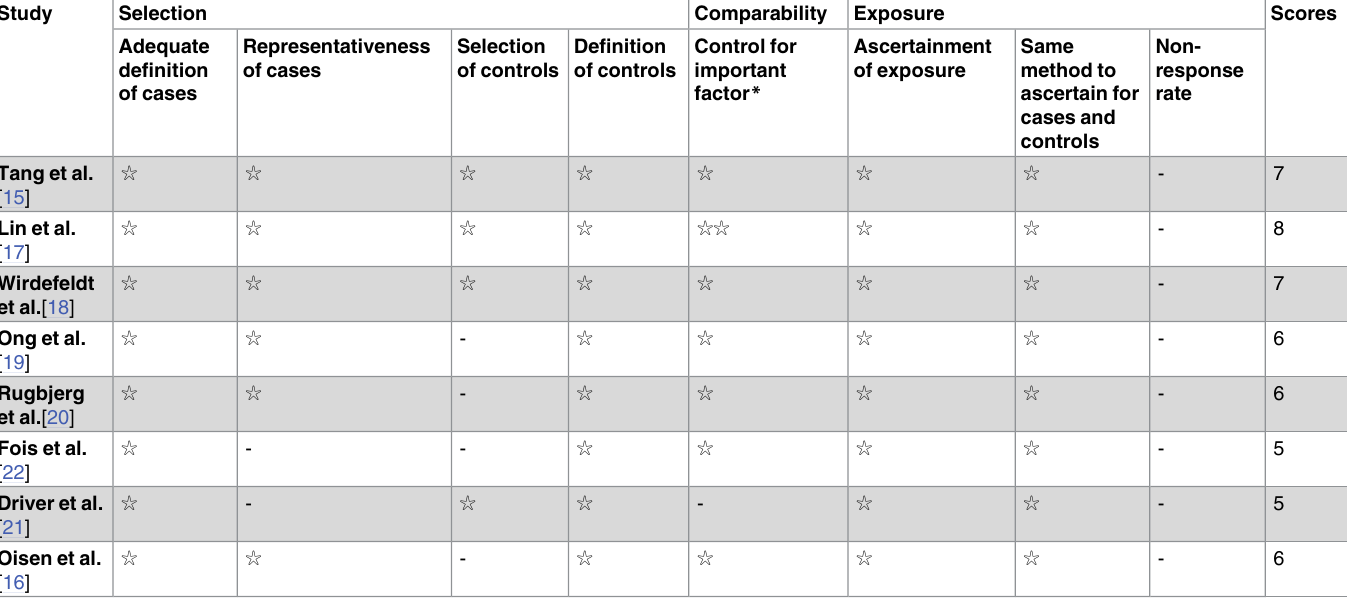
Table 2. The quality of the included studies assessedby